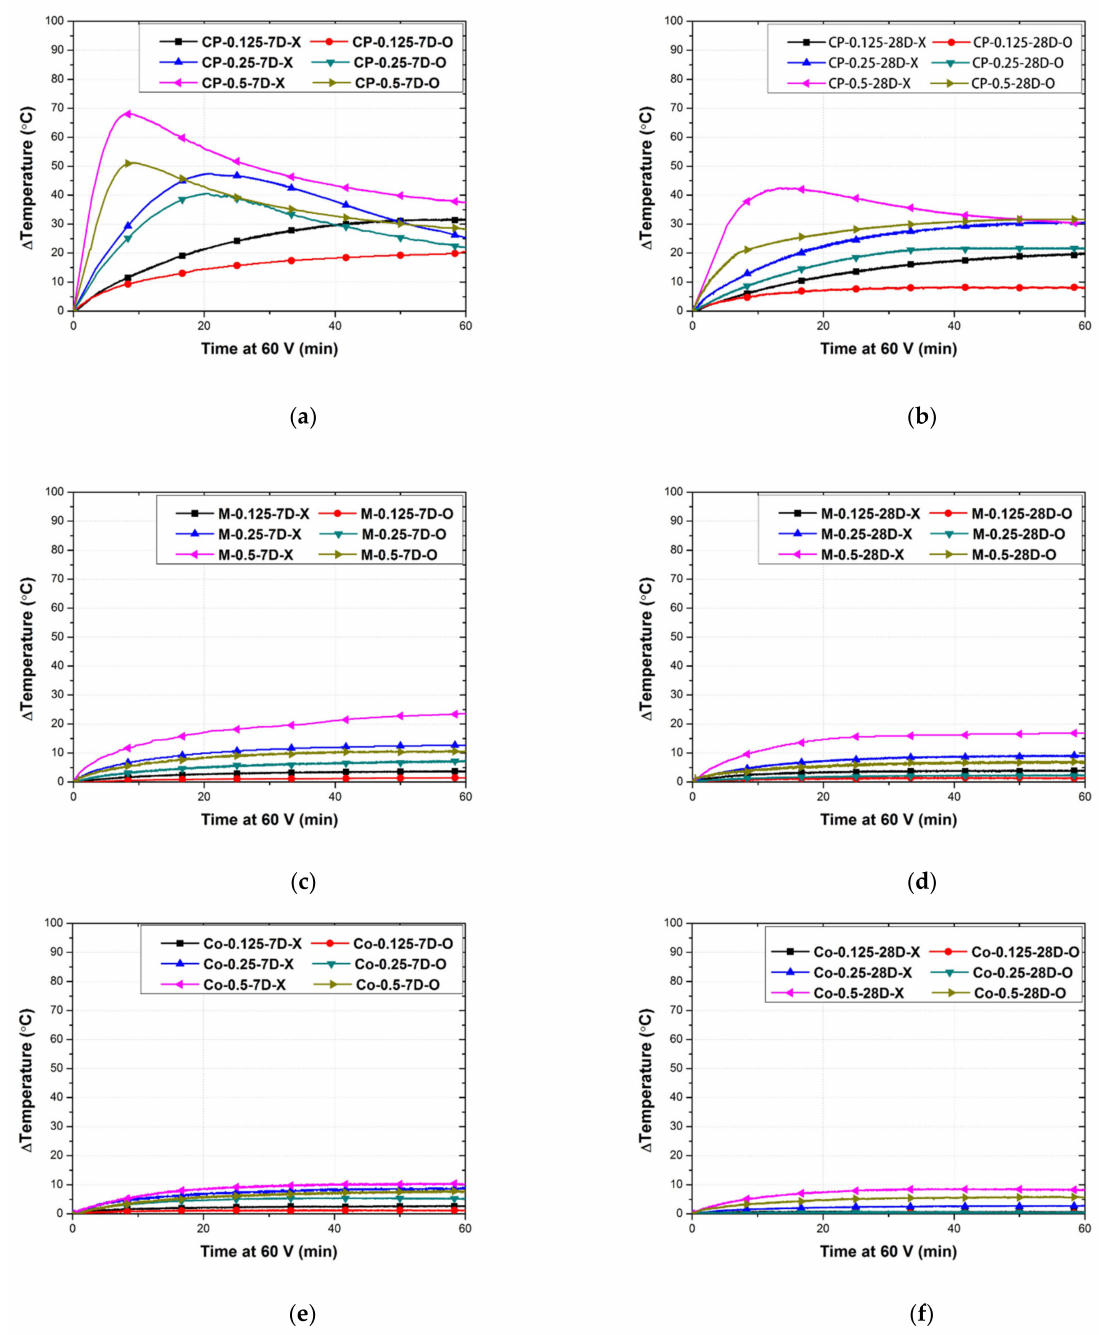
Figure 9. Temperature–time history: ( a ) cement paste (curing for 7 d), ( b ) cement paste (curing for 28 d), ( c ) mortar (curing for 7 d), ( d ) mortar (curing for 28 d), ( e ) concrete (curing for 7 d), and ( f ) concrete (curing for 28